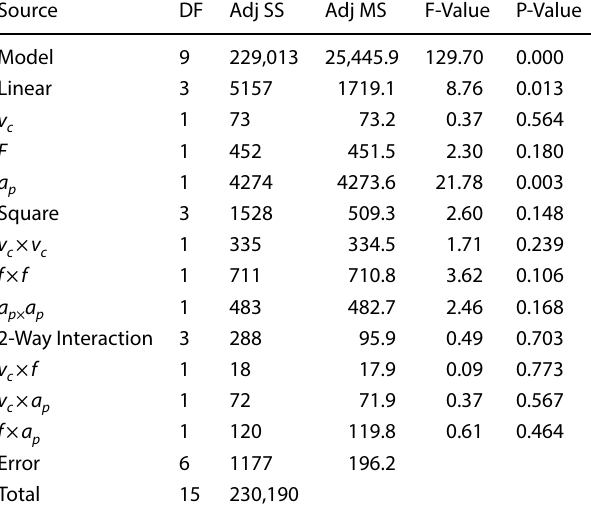
Fig. 8 Cutting force F z vs a